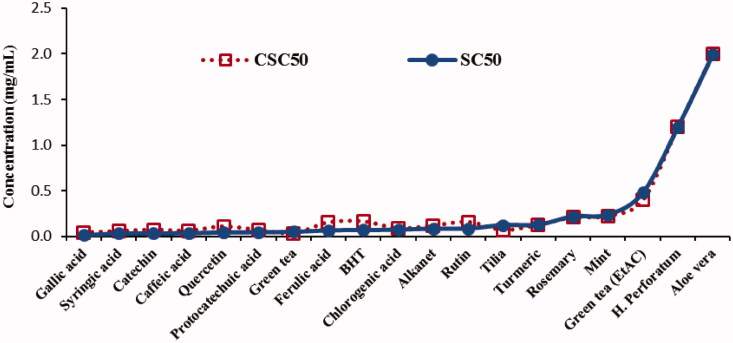
The SC50 and CSC50 values of standards and extracts (showing a good correlation with R2 = 0.9923).